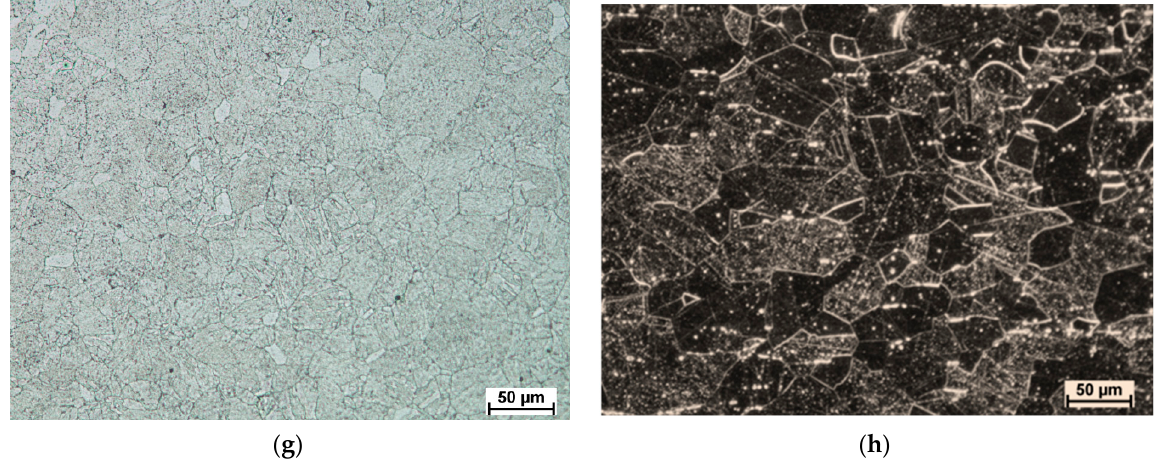
Figure 10. The microstructure of the samples taken for tests after rolling with a relative defor- mation ε = 0.18, Cooling variant I: ( a ) X2CrNiMo17-12-2 steel for a v = 1.0, ( b ) 10CrMo9-10 steel for a v = 1.0, ( c ) X2CrNiMo17-12-2 steel for a v = 0.75, ( d ) 10CrMo9-10 steel for a v = 0.75; Cooling variant